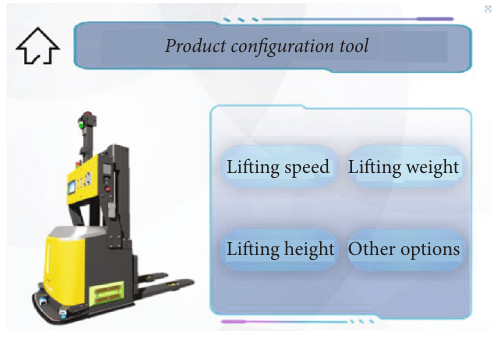
Figure 11: Quick con fi guration tool